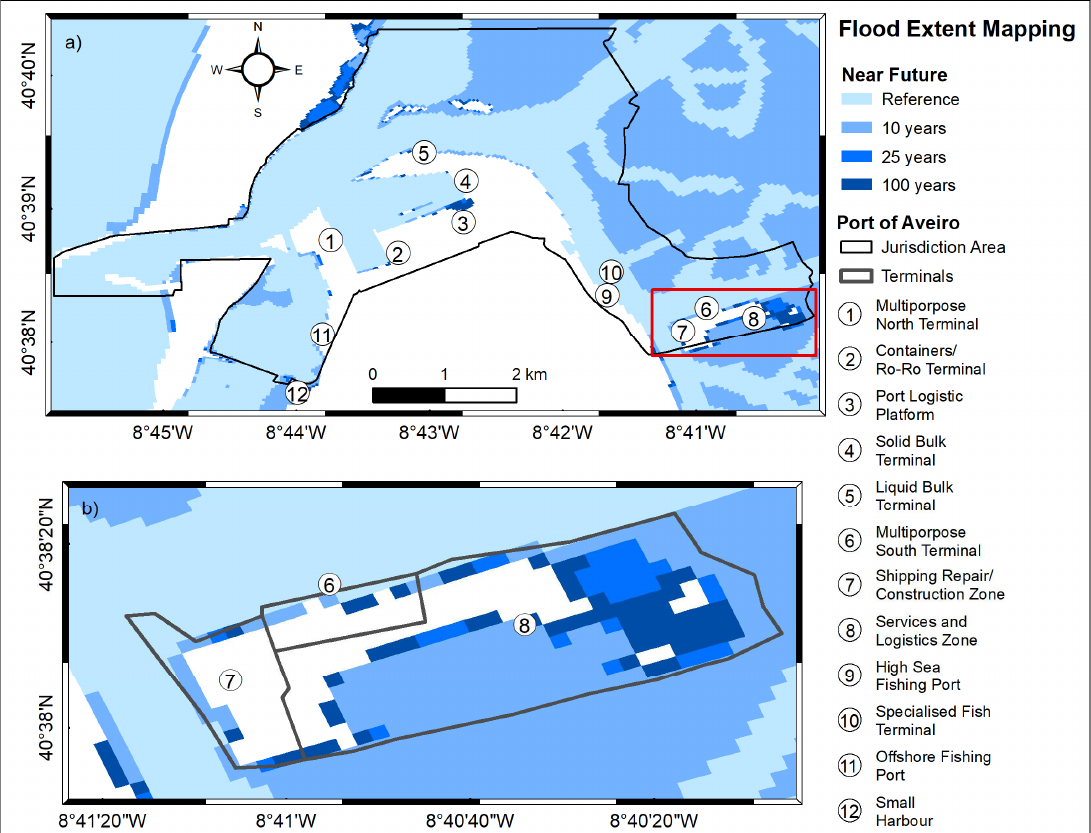
Figure 7. Flood extent mapping of the Aveiro Port’s terminals and zones (numbers 1–12) under its jurisdiction ( a ) (black line) and zoom of the most flooded area ( b ) (red line). Reference scenario under present climate and 10-, 25-, and 100-year return period are determined for the near future (2026–2045) climate